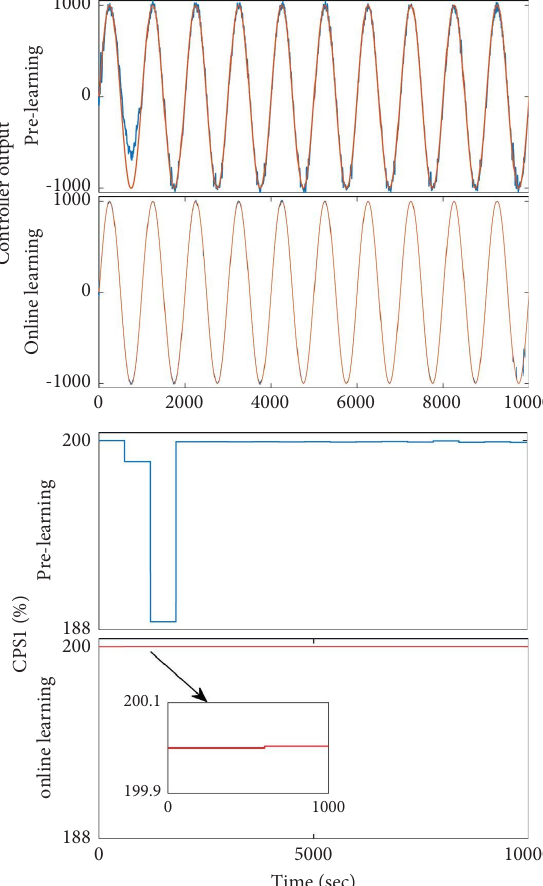
Figure 5: Microgrid pre-learning and online learning.